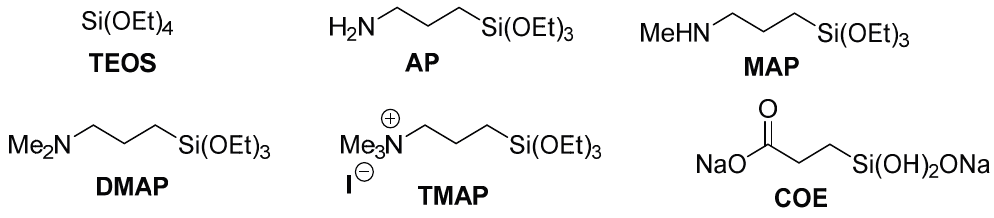
Figure 3. Structures of TEOS and the organically-modified siloxanes 3-aminopropyl- (triethoxy)silane ( AP ), 3-methylaminopropyl(triethoxy)silane ( MAP ), 3-dimethylamino- propyl(triethoxy)silane ( DMAP ), 3-triethoxysilylpropyltrimethylammonium iodide ( TMAP ), and carboxyethylsilanetriol, disodium salt ( COE